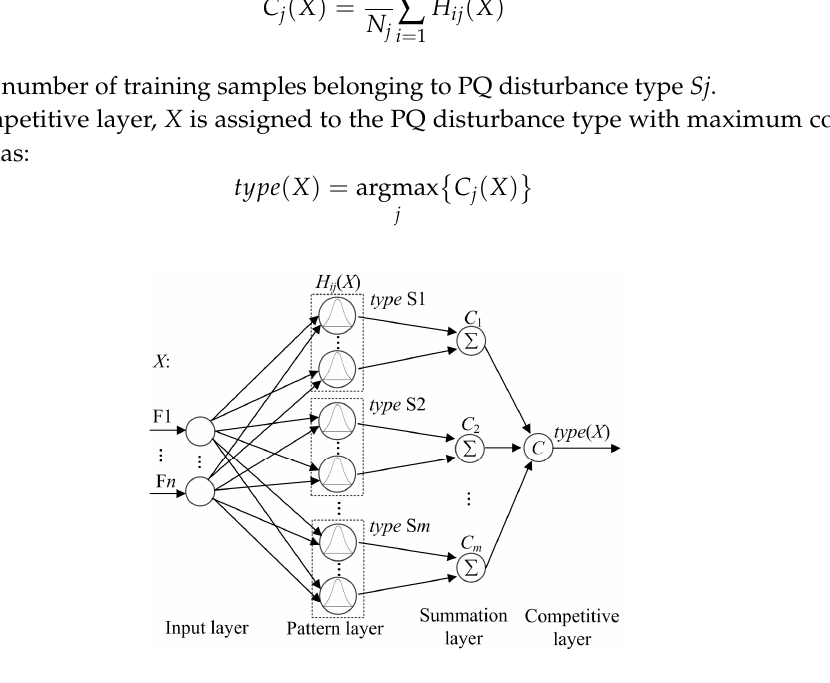
Figure 4. The schematic diagram of PNN.